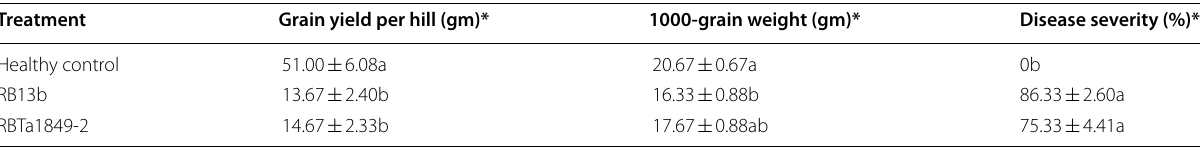
*Any two means having a common letter are not significantly different at the 5% level of